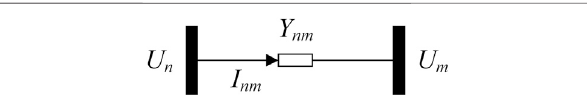
FIGURE 14 | The bus connection